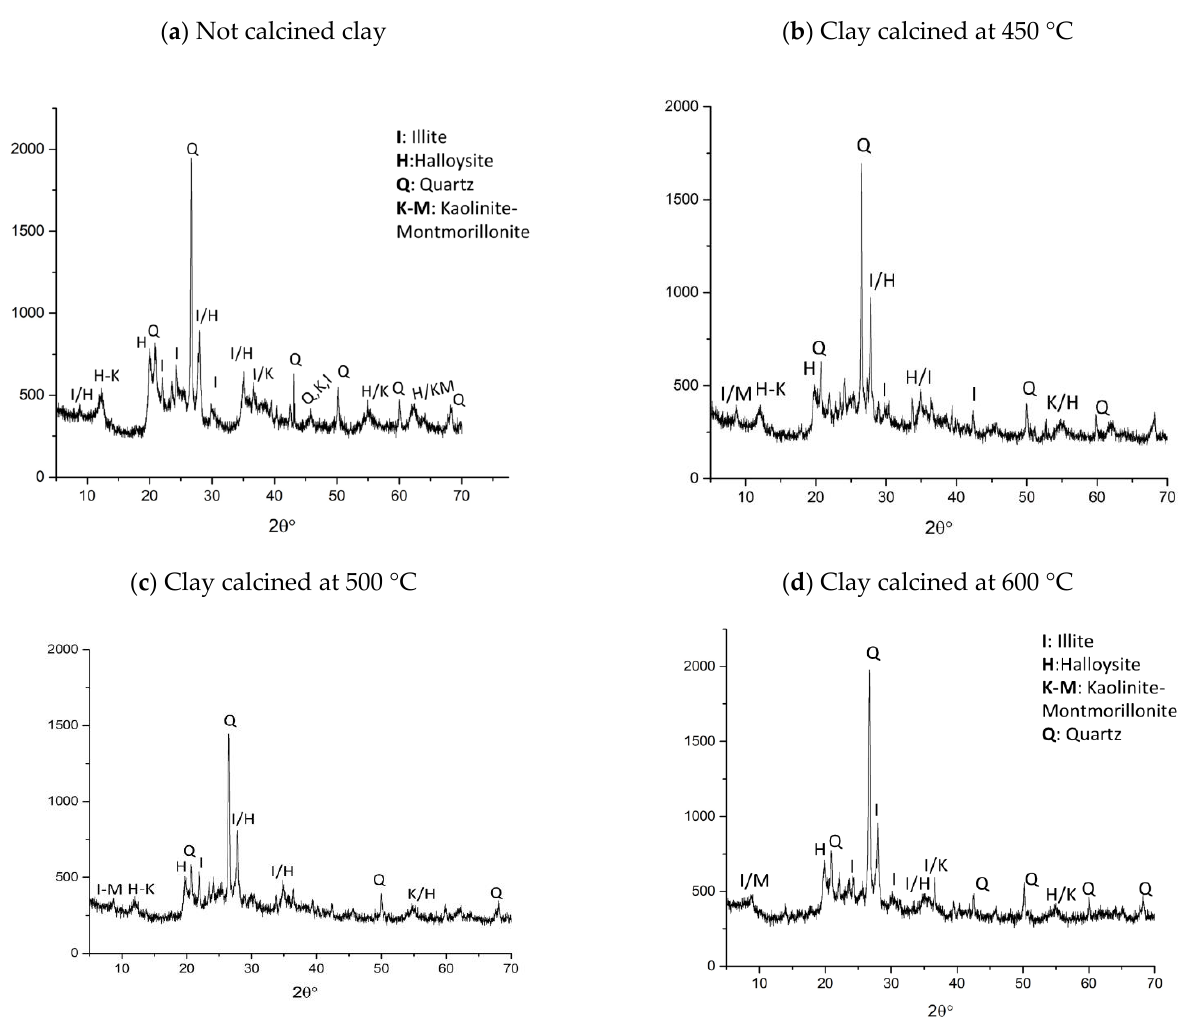
Figure 3. XRD patterns of clay: not calcined ( a ) and calcined at 450 °C ( b ), 500 °C ( c ), and 600 °C ( d ).